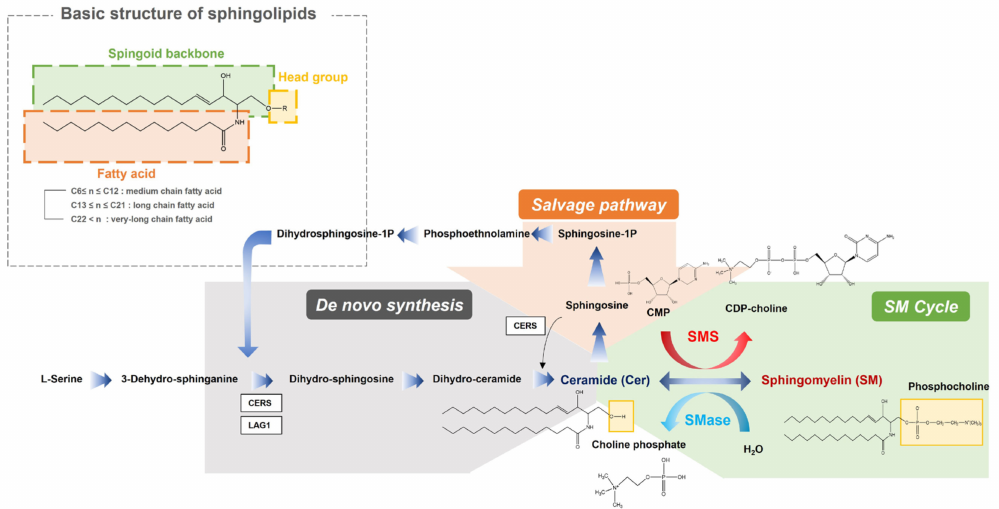
Figure 8. An overview of the integrated metabolic pathways in sphingolipids. SMS sphingomyelin synthase, SMase sphingomyelin phosphodiesterase, CDP-choline cytidine diphosphate-choline, CMP cytidine monophosphate, Sphingosine-1-P sphingosine 1-phosphate. Phospholipids and ether phospholipids (PC, PE, PlsPC, and PlsPE), which were